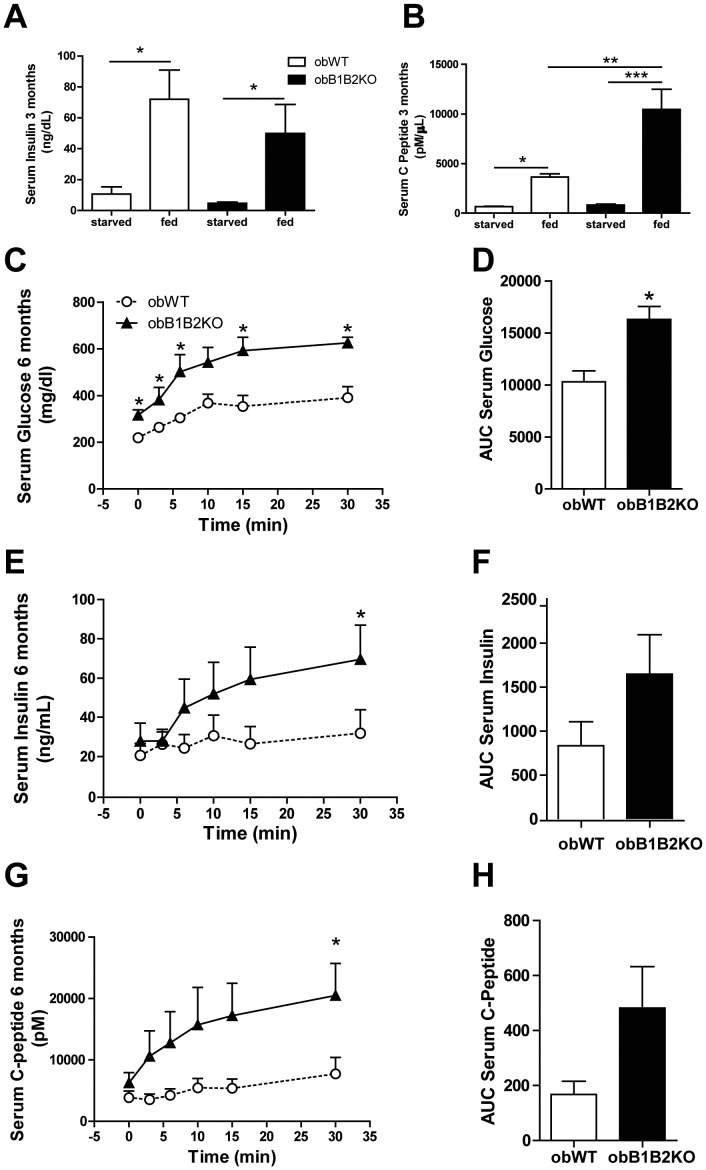
Three-month-old obB1B2KO mice have 2-fold more C-peptide levels.A) Serum insulin levels of starved and random fed mice at 3 months of age. B) Serum insulin C-peptide concentrations. C) Serum glucose after anesthesia with avertin and i.p. injection of 1 g glucose/kg body weight. D) Area under the curves of “C”. E and F) Serum insulin and, G and H) serum C-peptide from the same experiment in “C”. The data are presented as means ± SEM. *, p<0.05; **, p<0.01; ***, p<0.001, n = 8 for “A” and “B”, n = 4 for “C” to “H”.